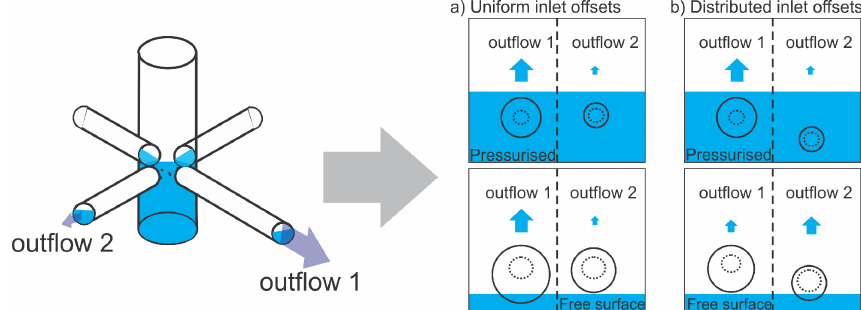
Figure 9. Left panel: the geometry of a junction. Right panels ( a, b ): scheme of two outflows during pressurized flow (top panels) and free-surface flow (bottom panels). (a) Initial inlet offsets for both outflows are equal. (b) Initial inlet offset of outflow 2 is smaller so that the outflow has a lower elevation. Blue arrows indicate the amount of flow drained by each outflow, and the blue shading indicates the water